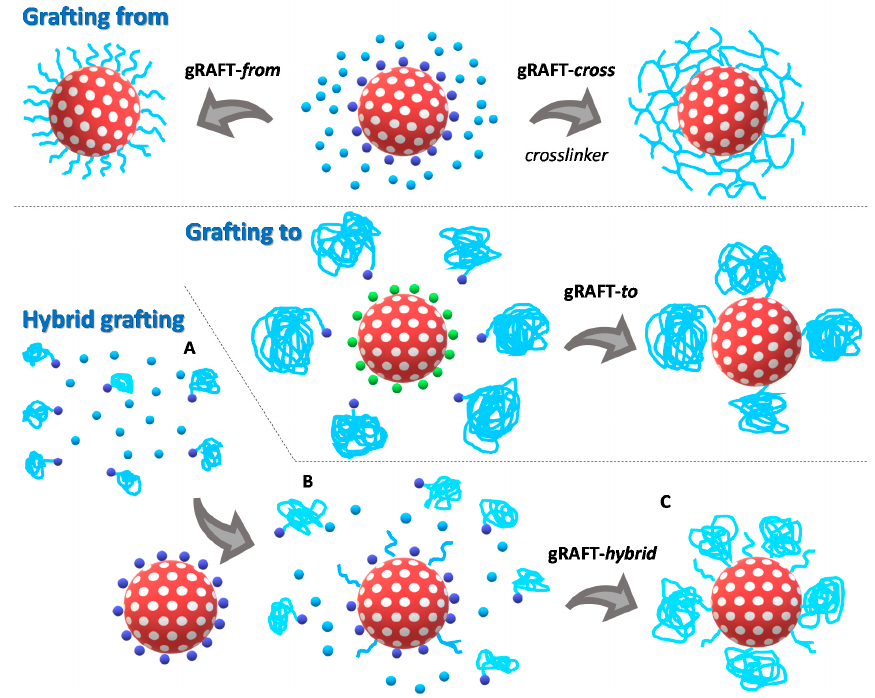
Figure 1. Grafting strategies used to incorporate a pH-responsive polymer on the surface of mesoporous silica nanoparticles (MSNs). In the “grafting from” approach (gRAFT- from ) the monomer 2–(diisopropylamino) ethyl methacrylate (DAEM, light blue spheres ) polymerization is mediated by the CTA ( dark blue spheres ) anchored at the surface of the MSNs ( porous red spheres ), therefore,